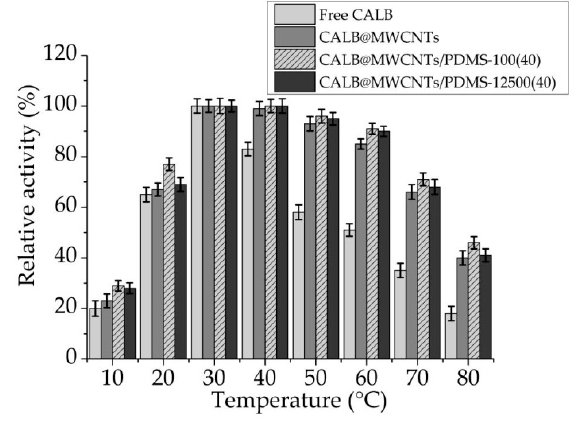
Figure 5. Temperature profiles of free lipase and enzyme immobilized onto P-MWCNTs and MWCNTs/PDMS nanocomposites.